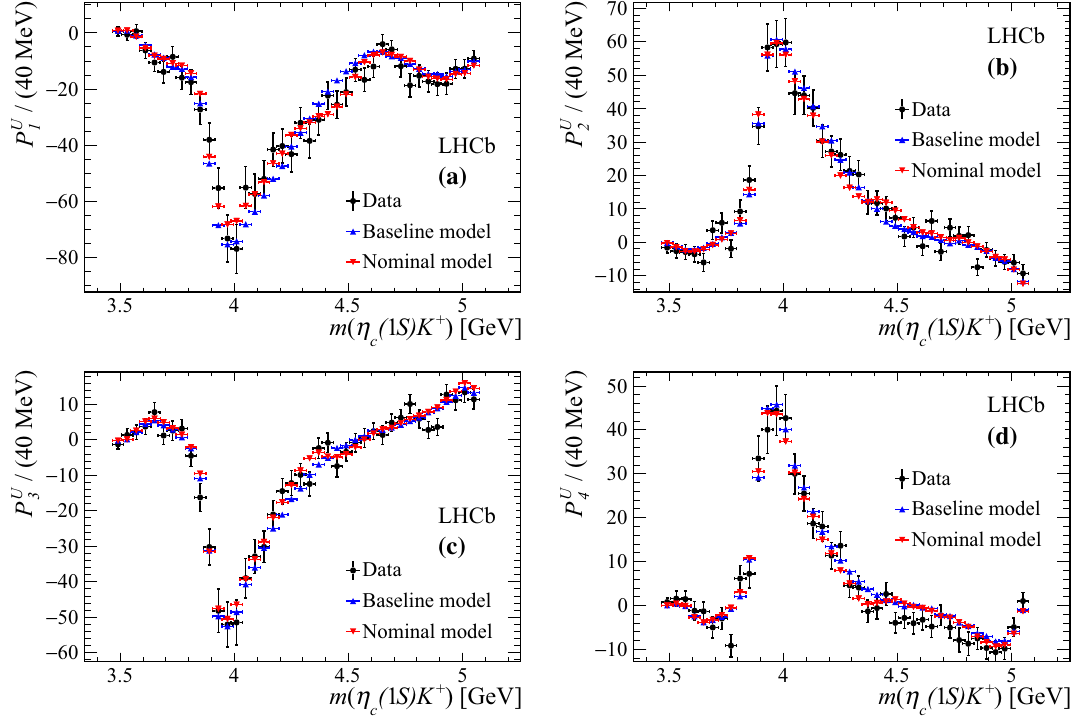
Fig. 12 Comparison of the first four η c K + Legendre moments determined from background-subtracted data (black points) and from the results of the amplitude fit using the baseline model (red triangles) and nominal model (blue triangles) as a function of m (η c K +